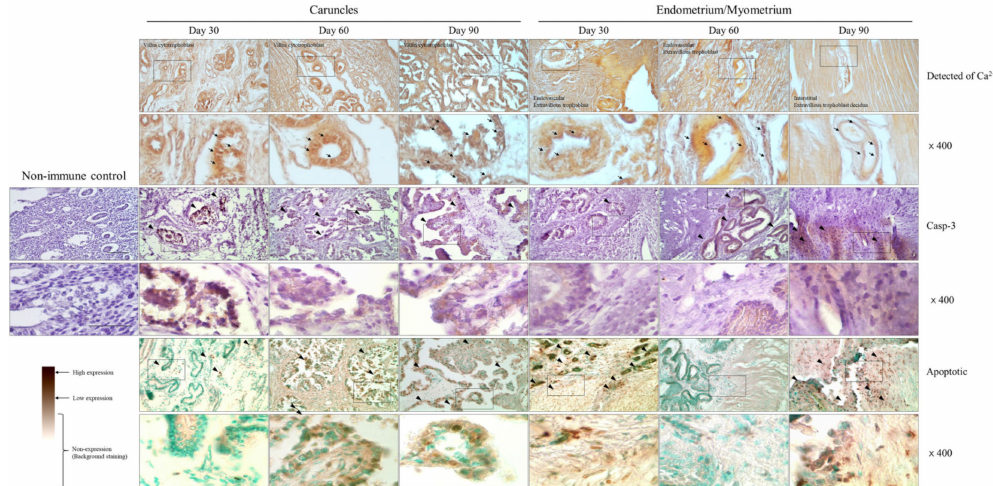
Figure 5. Expression and localization of calcium, Casp-3, and apoptotic label in the endometrium and caruncle tissue during early pregnancy. Endometrial tissue sections were immunostained with Casp-3 antibody and counterstained with hematoxylin. Brown indicates gene expression. In the apoptotic detection assay, terminal deoxynucleotidyl transferase was used to label the 3 (cid:48) -OH terminus of DNA fragments generated during apoptosis. For detection, HRP-conjugated anti-FITC (1:200) and DAB kit were used. Dark brown areas indicate the site of apoptosis. In the calcium analysis, the black arrows indicate calcium-positive trophoblast cells. Black arrows in other assays indicate the detection of proteins or apoptotic. Magnification = × 200, × 400. Scale bar = 100 µ